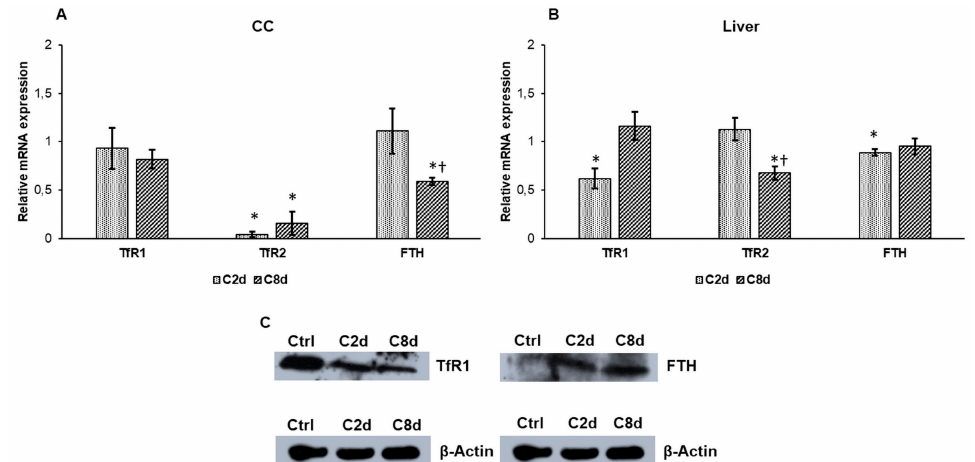
Figure 4. Relative mRNA expression values of transferrin receptor 1 (TfR1), transferrin receptor 2 (TfR2), and Ferritin heavy chain (FTH) and protein levels of TfR1 and FTH in CZ-treated groups. Real Time PCR was performed with SYBR green protocol using gene specific primers. β -actin was used as housekeeping gene for the normalization and relative expression of controls was regarded as 1. Western blot analyses were made from protein extracts of the liver tissue samples. Nitrocellulose membranes were probed with TfR1 and FTH polyclonal rabbit antibodies according to the manufacturer’s protocols. β -actin was used as loading control. ( A ) TfR1, TfR2, and FTH mRNA expressions in CC. ( B ) TfR1, TfR2, and FTH mRNA expression levels in the liver. ( C ) TfR1 and FTH protein expression levels in the liver. The Western blot experiments were repeated at least three times in each group. The bars represent mean values and error bars represent standard errors of the mean (SEM) for three independent determinations. For statistical analyses, Student’s t -test and two-sample t -tests were used. The asterisk shows p < 0.05 compared to the controls, while the cross indicates a di ff erence p < 0.05 between the treated groups, n = 6 in each group. Optical density analyses can be seen in Figure